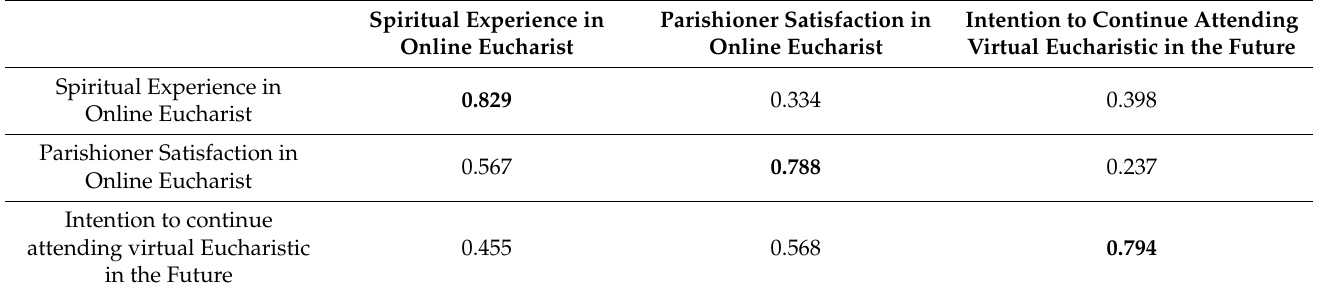
Table 5. Discriminant validity.